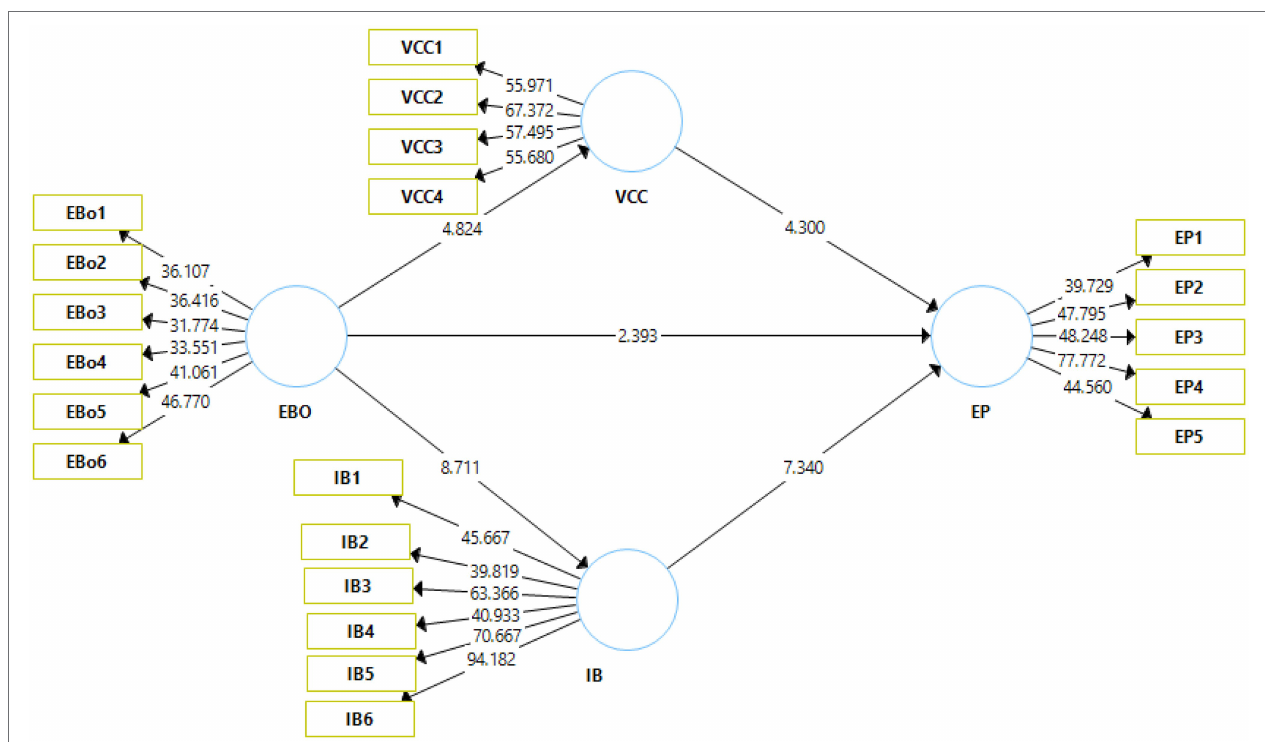
FIGURE 3 | Output of structural model bootstrapping. EBO, enterprise brand orientation; VCC, customer value co-creation; IB, internal branding; EP, brand TABLE 4 | Direct effects of the variable. Paths H O T -statistics Value of p Results Enterprise Brand Orientation → Brand Performance